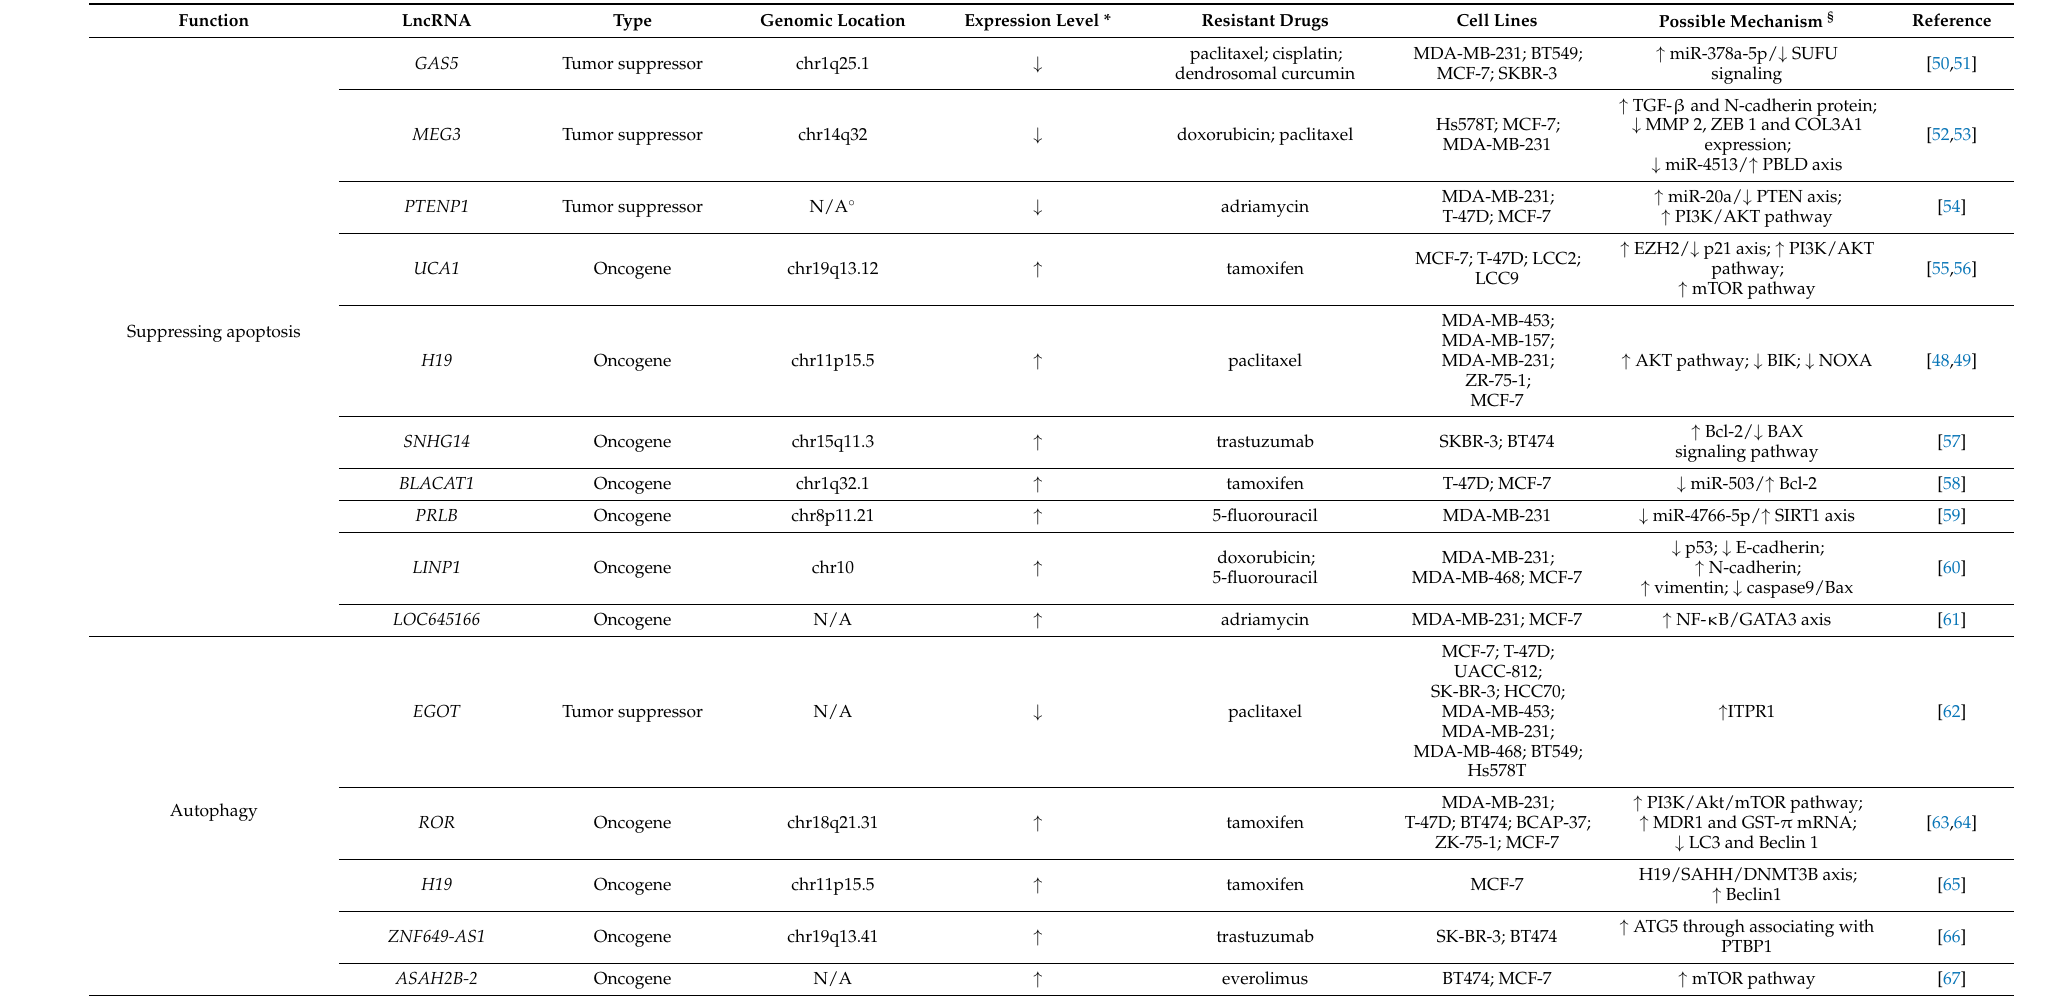
Table 1. The role of lncRNAs in regulating cell survival and death in chemoresistance breast